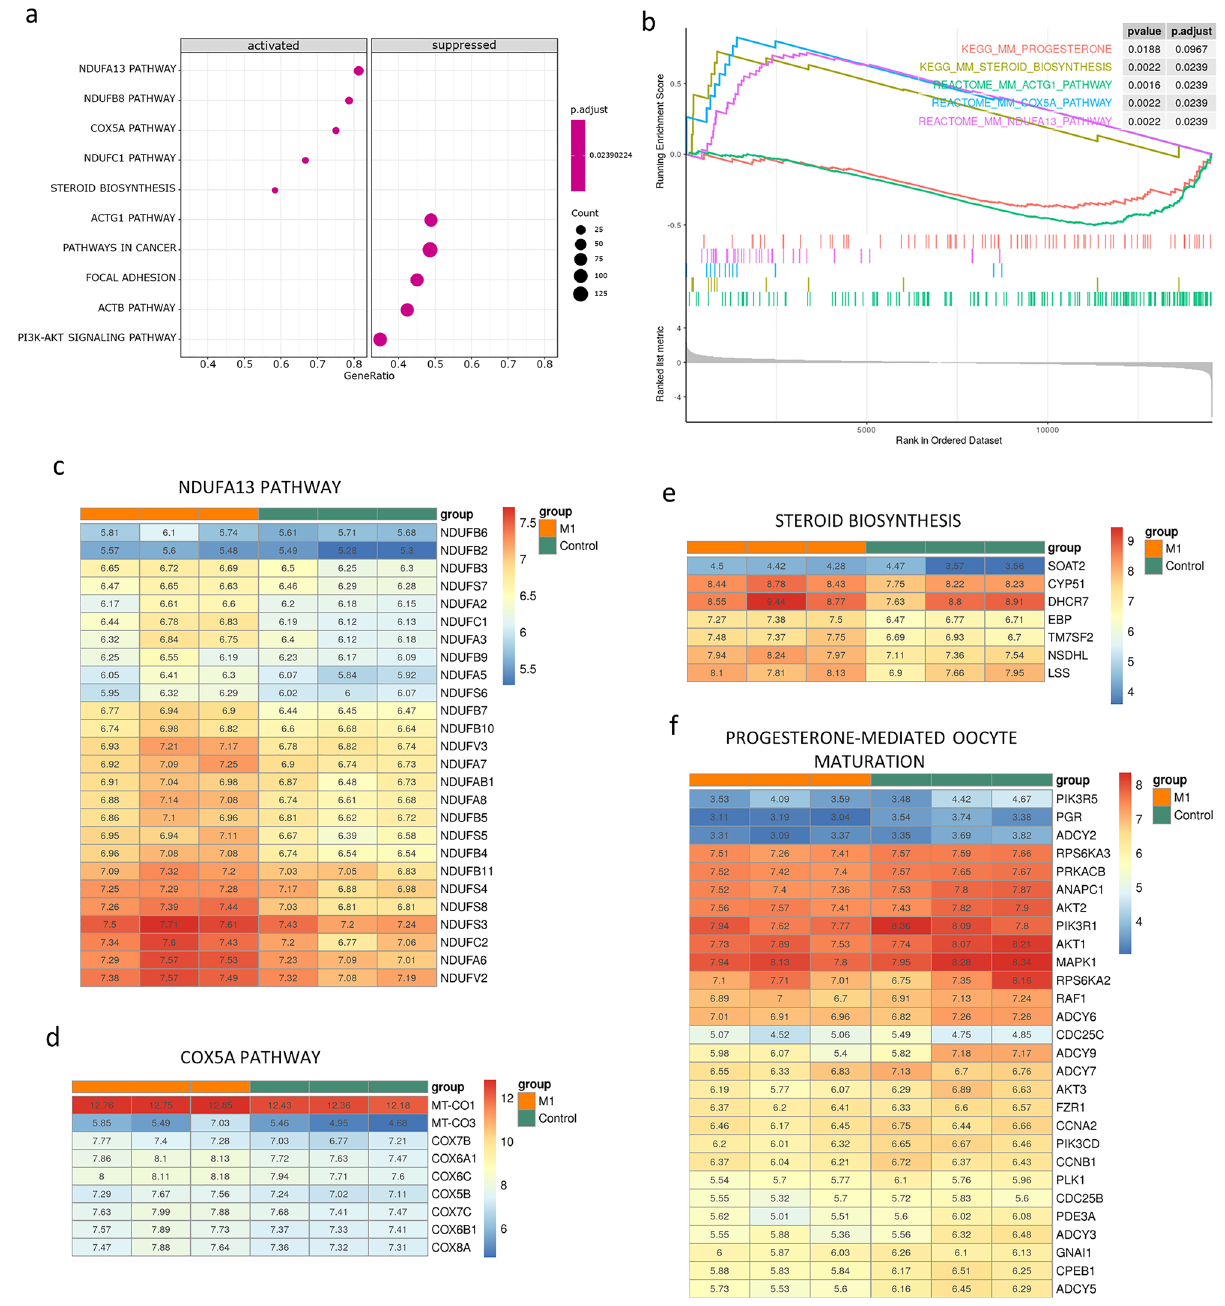
( b ). The details of gene expressions for NDUFA13 ( c ) COX5A ( d ), steroid biosynthesis pathway heatmap ( e ), and progesterone-mediated oocyte maturation ( f ) were shown in heatmaps. The expression levels were normalized and shown as relative log expressions